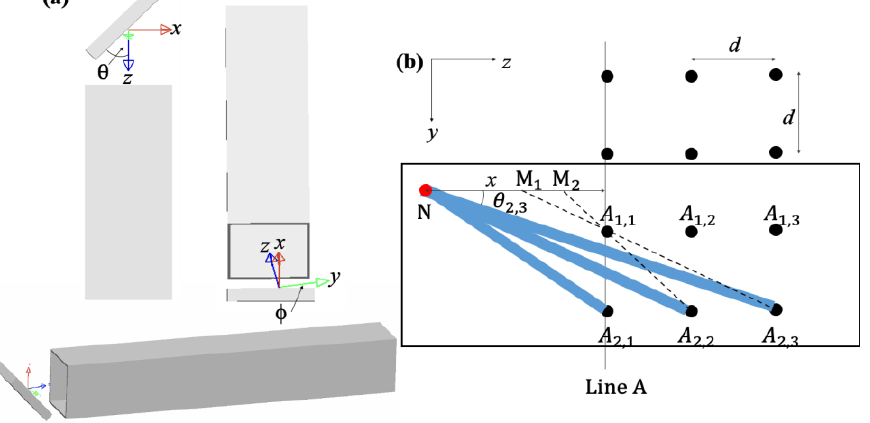
Figure 6. ( a ) The arrangement of a pair consisting of mirror and reflective channel. (φ) and (θ) are the angles of the mirror with respect to the vertical ( x–y ) and transverse ( y–z ) planes. Note also that θ = 45 ◦ to ensure that all redirected beams from mirrors would be parallel to the transverse plane. ( b ) Design rule of mirror + reflective channel in terms of φ-angle to comply that all beams are guided to a sole area at the exit of the secondary concentrator, N.